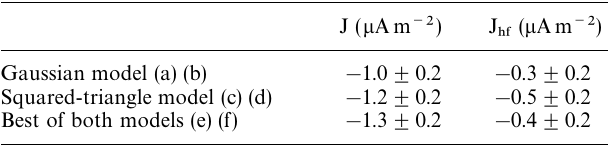
Table 1. 95% confidence interval for the currents J without heat- flow correction and J (cid:41)(cid:38) with heat-flow correction from the histo- grams of Fig. 10 J ( (cid:108) Am (cid:126)(cid:50)